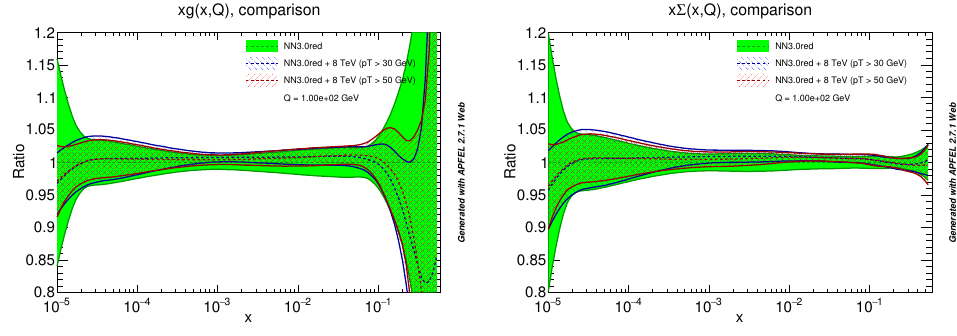
Figure 17 . Impact of the choice of p Z